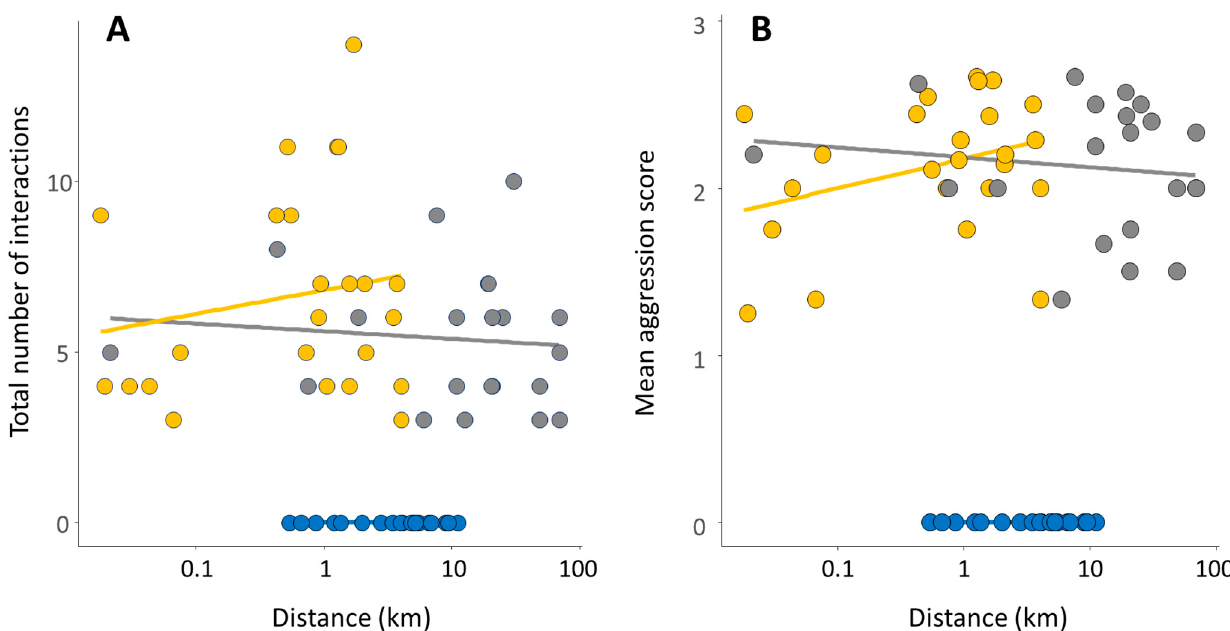
Figure 3. Scatterplot with regression lines for total number of interactions ( A ) and mean aggression scores ( B ) for five-minute pairwise trials within each population in relation to the geographical distance between test-pair colonies. A total of 67 trials were run from three populations (Hachijojima (blue circles, n = 22), Okinawa (grey circles, n = 21), and Chichijima (yellow circles, n = 24)).